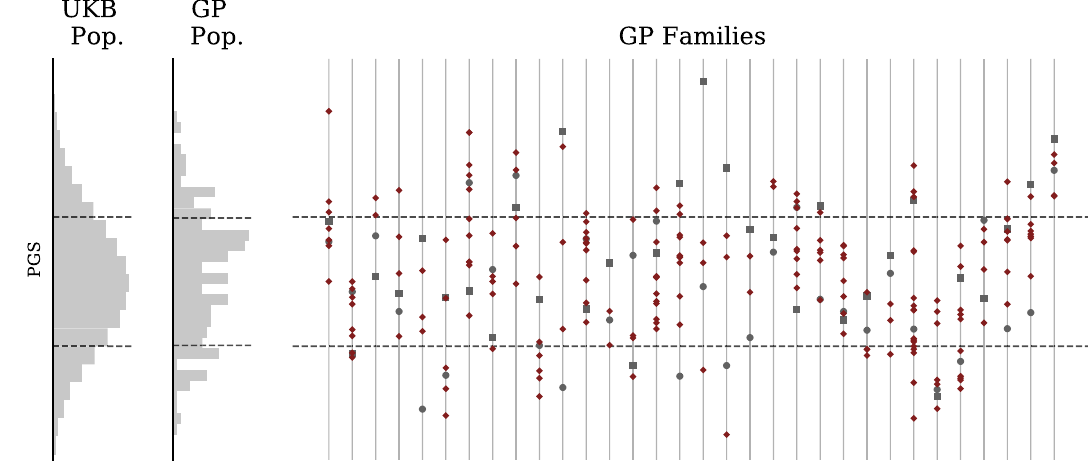
Figure 7. Type 2 Diabetes Polygenic Risk Score for GP/IVF families (uncentered). Far left histogram describes UKB general population. Middle histogram describes GP IVF embryos in aggregate (note this is a mixture of highly-related (sibs) (sibs from different families). Individual families are displayed on the right with mother represented by a circle and father by a square. Note siblings can have higher or lower PGS than either parent. Horizontal lines indicate standard deviations in the general populations.